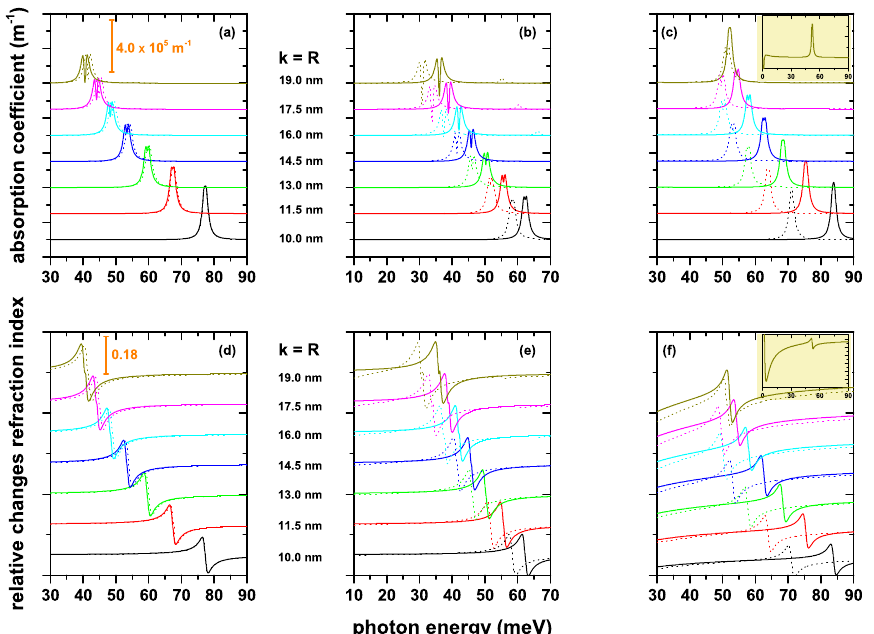
Figure 7. Optical absorption coefficient ( a – c ) and relative changes of the refraction index ( d – f ) as a function of the incident photon energy for a confined electron within the CQD. Calculations are for several values of the k = R parameters for zero (solid lines) and F = 50kV/cm (dotted lines), considering transitions between l = 0 states. The results are reported for the three consid- ered axial finite confinement potentials: V 2 ( z ) ( a , d ), V 3 ( z ) ( b , e ) and V 4 ( z ) ( c , f ). The insets in ( c , f ) show the optical coefficients for k = R = 19nm for the energy photon between zero and 90meV in order to see the transitions between states that are almost degenerated. ( a , d ) show the scales for the optical